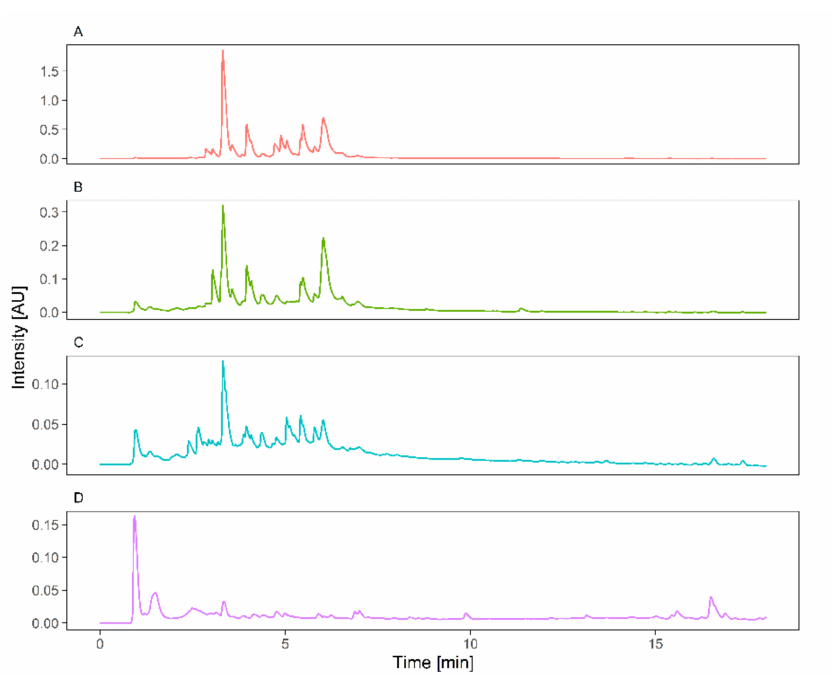
Figure 4. The UPLC-PDA (254 nm) chromatograms of Linnaea borealis var. borealis extracts of leafy shoots from natural sites (purple, D ); shoot cultures (red, A ); roots from micropropagated plantlets (green, B ); biomass from callus cultures (blue, C